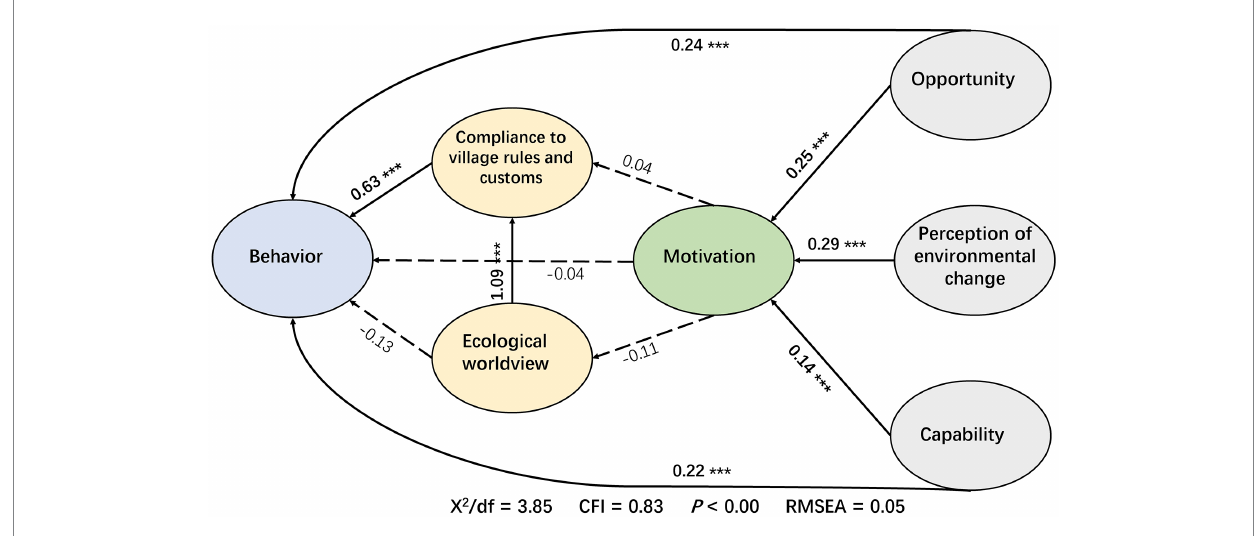
FIGURE 6 The summary of SEM results (Model 1) of the sustainable harvesting behavior ( N = 923). Path estimates are standardized coefficients. The solid line indicates significant correlation between variables, and the dotted line indicates not significant correlation between variables. Significant coefficient is marked in bold. *** p ≤